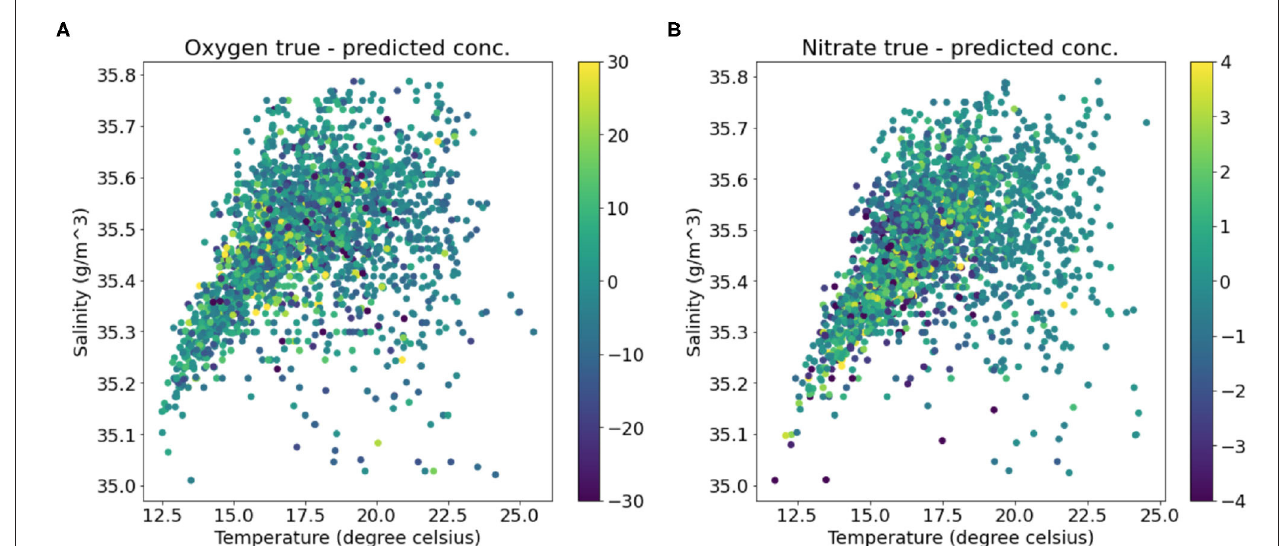
FIGURE 7 | Temperature-Salinity diagrams colored by (A) the error in the predicted oxygen concentrations and (B) the error in the predicted nitrate concentrations.